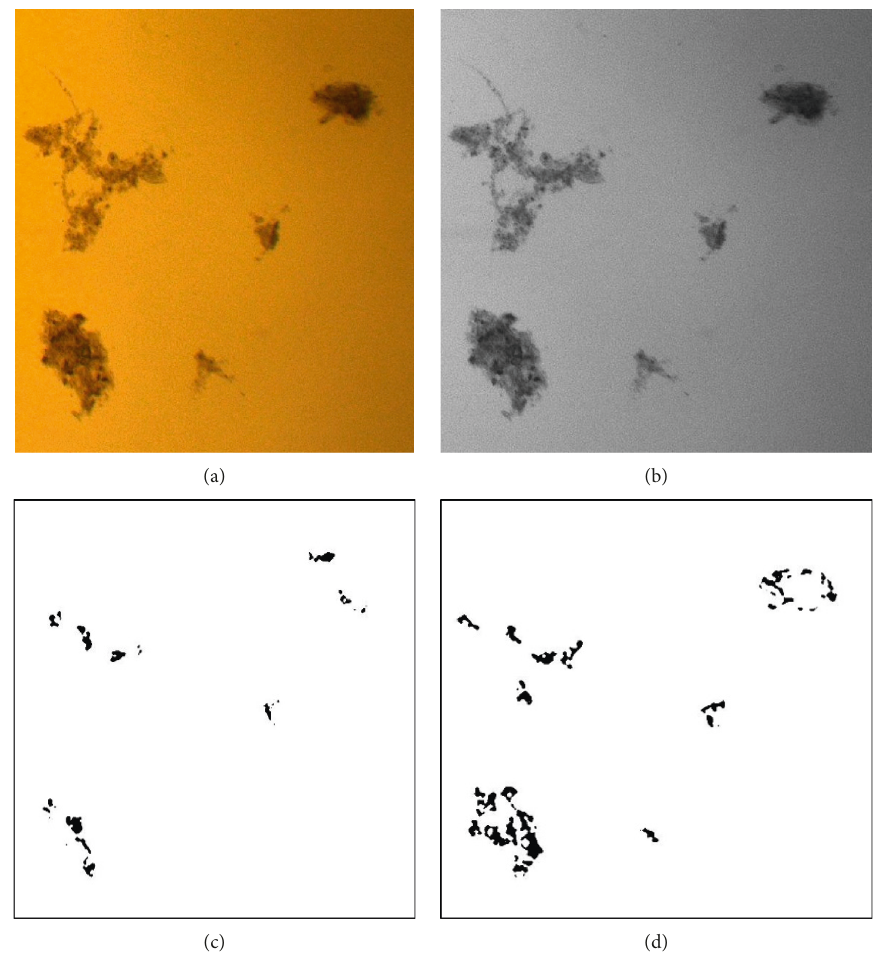
Figure 6: Image 3 segmentation results: (a) original image, (b) grayscale image, (c) segmentation results using Canny, and (d) segmentation results using our